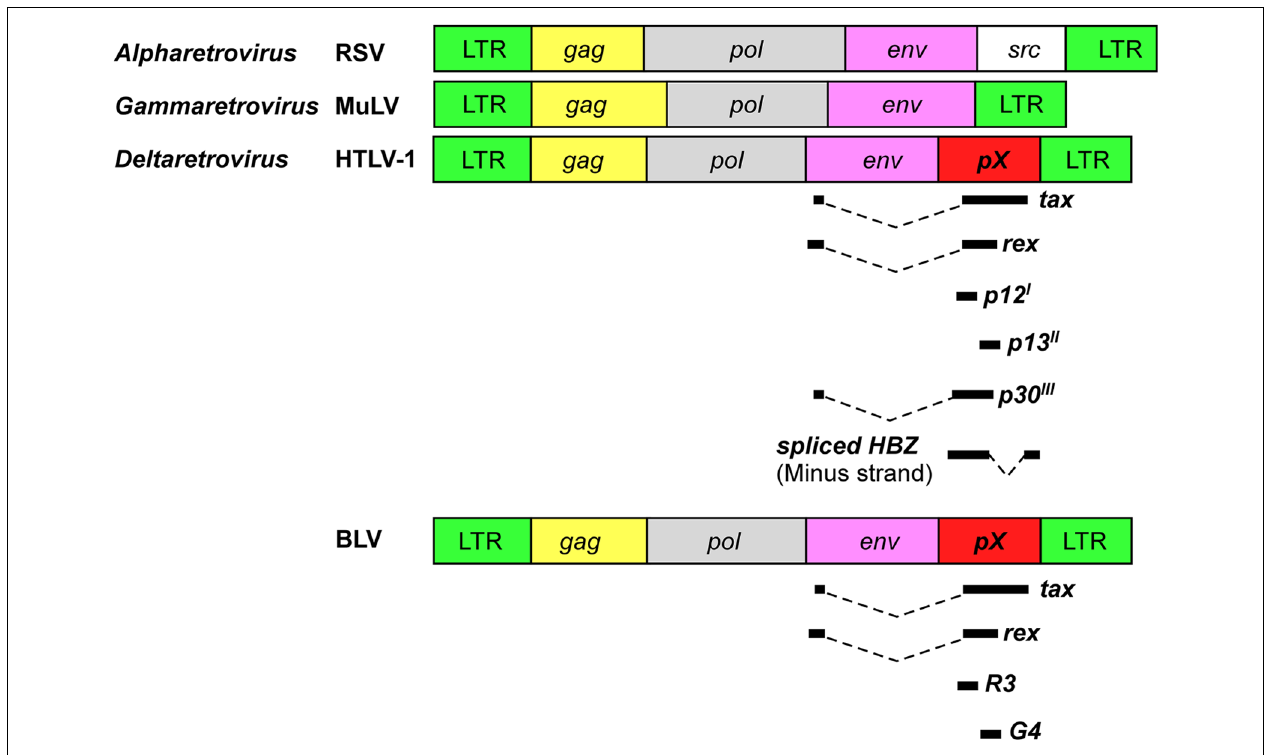
FIGURE 1 | Schematic representation of genome organization of retroviruses. HTLV-1 and BLV encode unique regulatory and accessory proteins in the pX region. RSV, Rous sarcoma virus; MuLV, murine leukemia